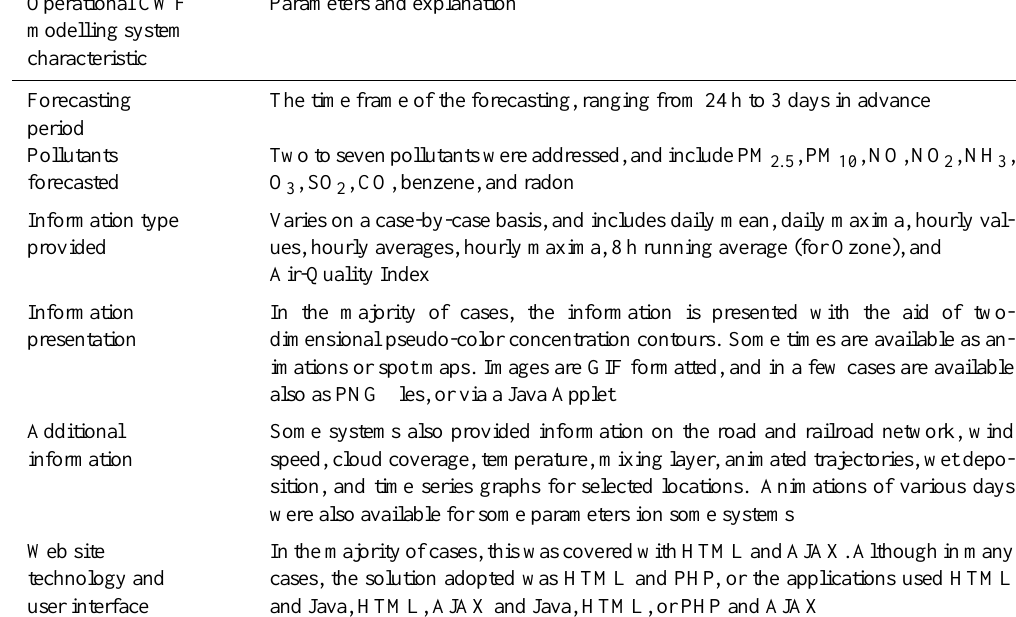
Table 12. Dissemination of CWF system predictions in the Internet. The results correspond to characteristic properties for European regional-scale CWF systems (Balk et al.,